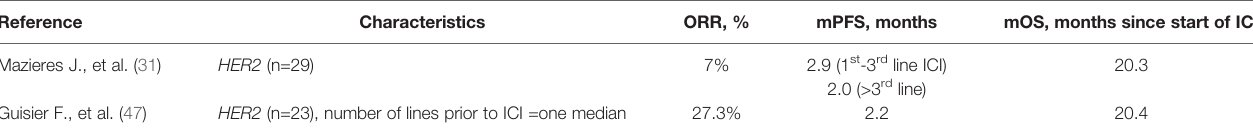
TABLE 8 | Ef fi cacy of ICIs in NSCLS with HER2